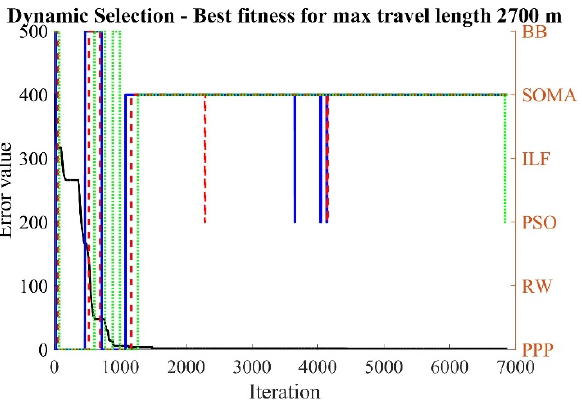
Figure 30. Dynamic search strategy selection utilising membership function set 2: Example selection of search strategies over simulation time.